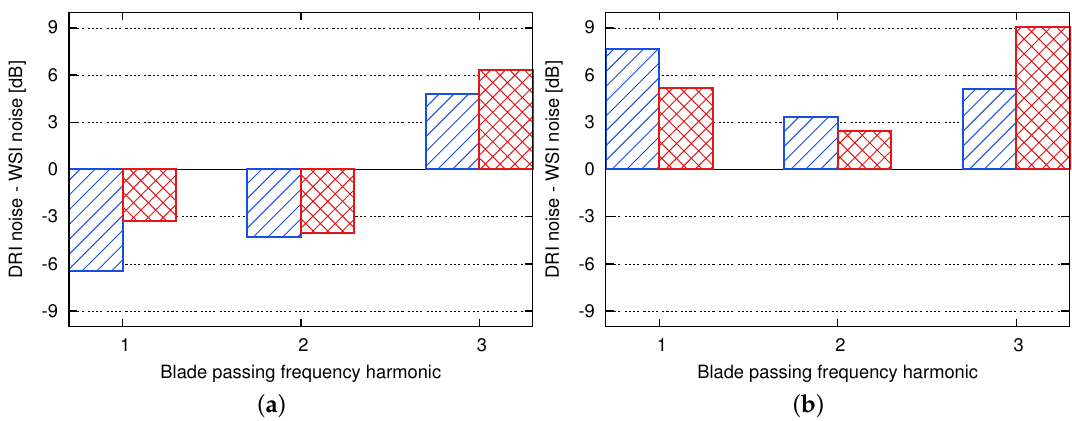
Figure 17. Comparison of DRI noise and WSI noise: the axisymmetric case in hatched blue bars and the asymmetric case in crosshatched red bars. ( a ) Upstream; ( b ) downstream.